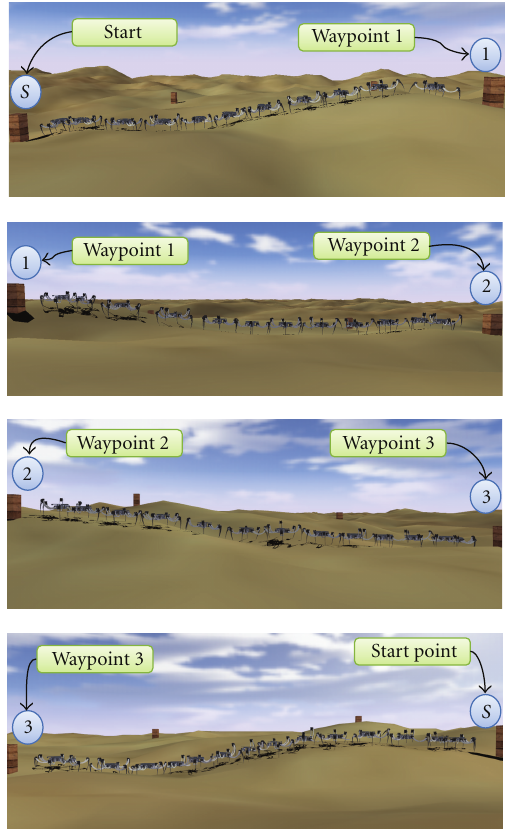
Figure 21: Locomotion of robot in visual simulation environment to show the body attitude